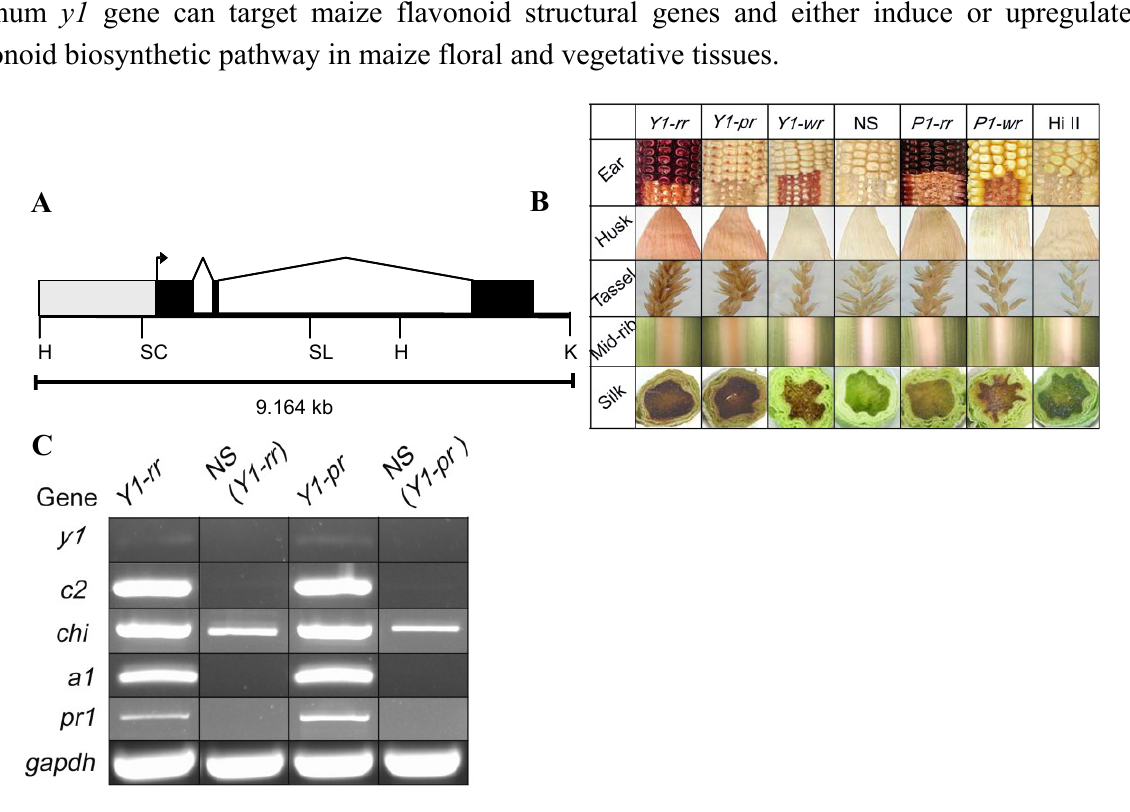
Figure 2. Characterization of y1 transgenes. ( A ) Structural features of the sorghum y1 gene. The gray box represents the upstream regulatory region. The bent arrow indicates the transcription start site. Solid boxes correspond to exons that are joined by angled lines representing introns. The restriction enzyme sites shown are: H, Hin dIII; K, Kpn I; SL, Sal I; SC, Sca I. Illustration not drawn to scale. ( B ) Sorghum y1 gene-induced pigmentation phenotypes in transgenic Y1- maize. Three y1 transgenic events representing Y1-rr , Y1-pr and Y1-wr were characterized for ear, husk, tassel glumes, leaf mid-rib, and silk